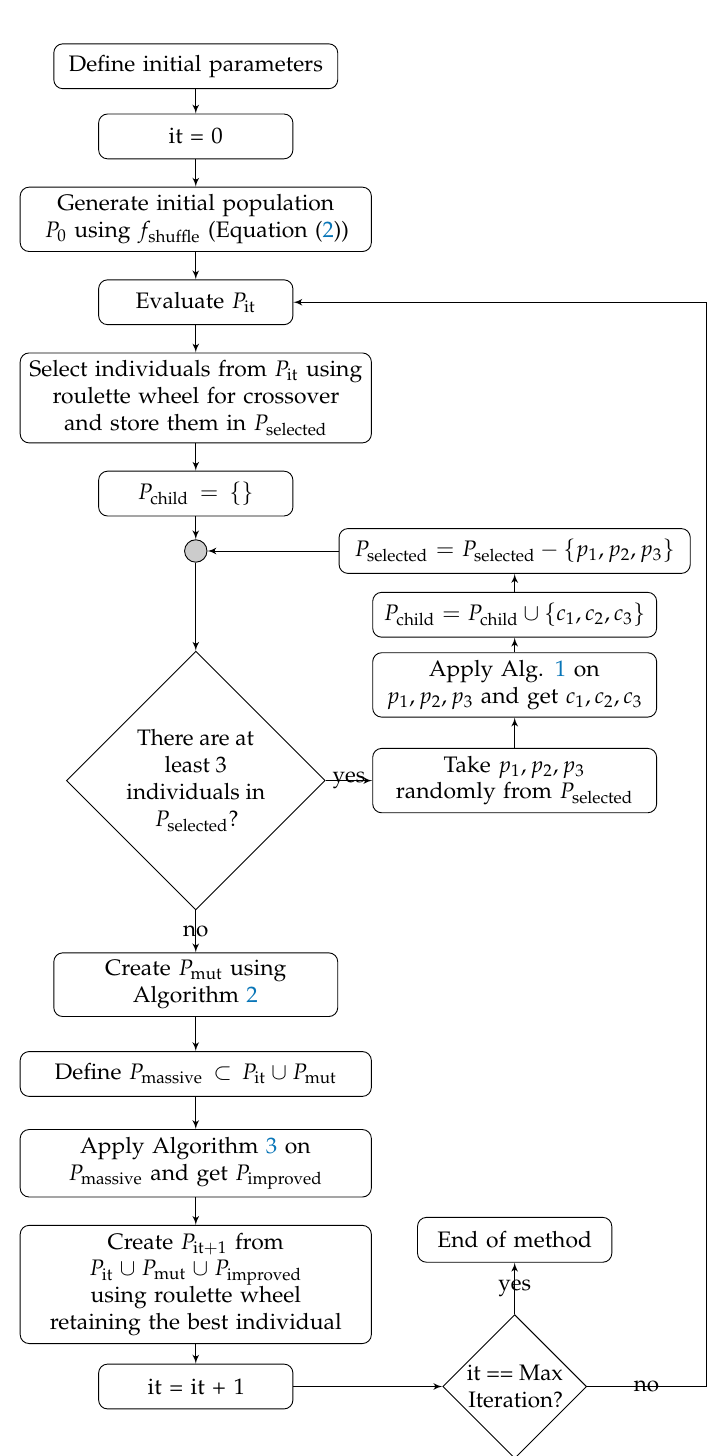
Figure 4. Flow chart of our proposed Multi-Crossover Local Search Genetic